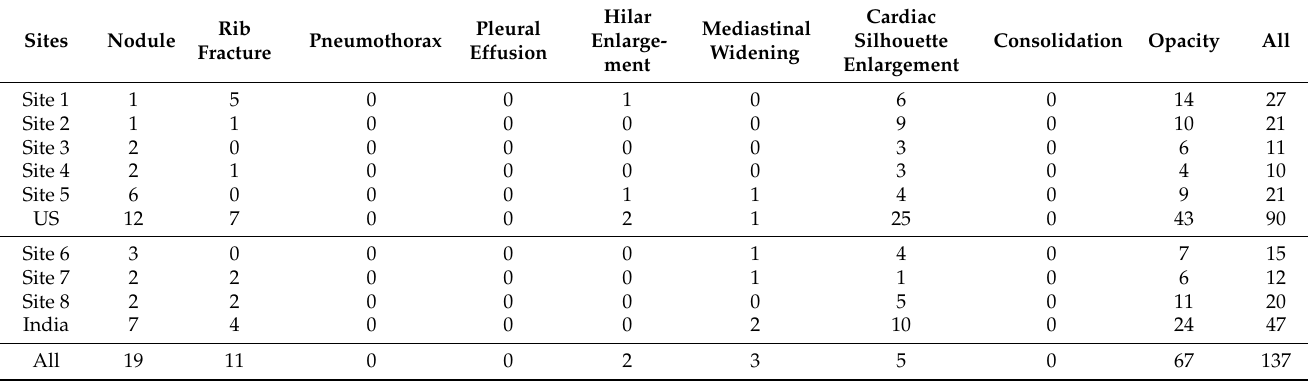
Table 1. Summary of site-wise distribution of missed findings (per radiologist ground truth) with “no or likely no” clinical importance, which were not documented in the radiology reports.